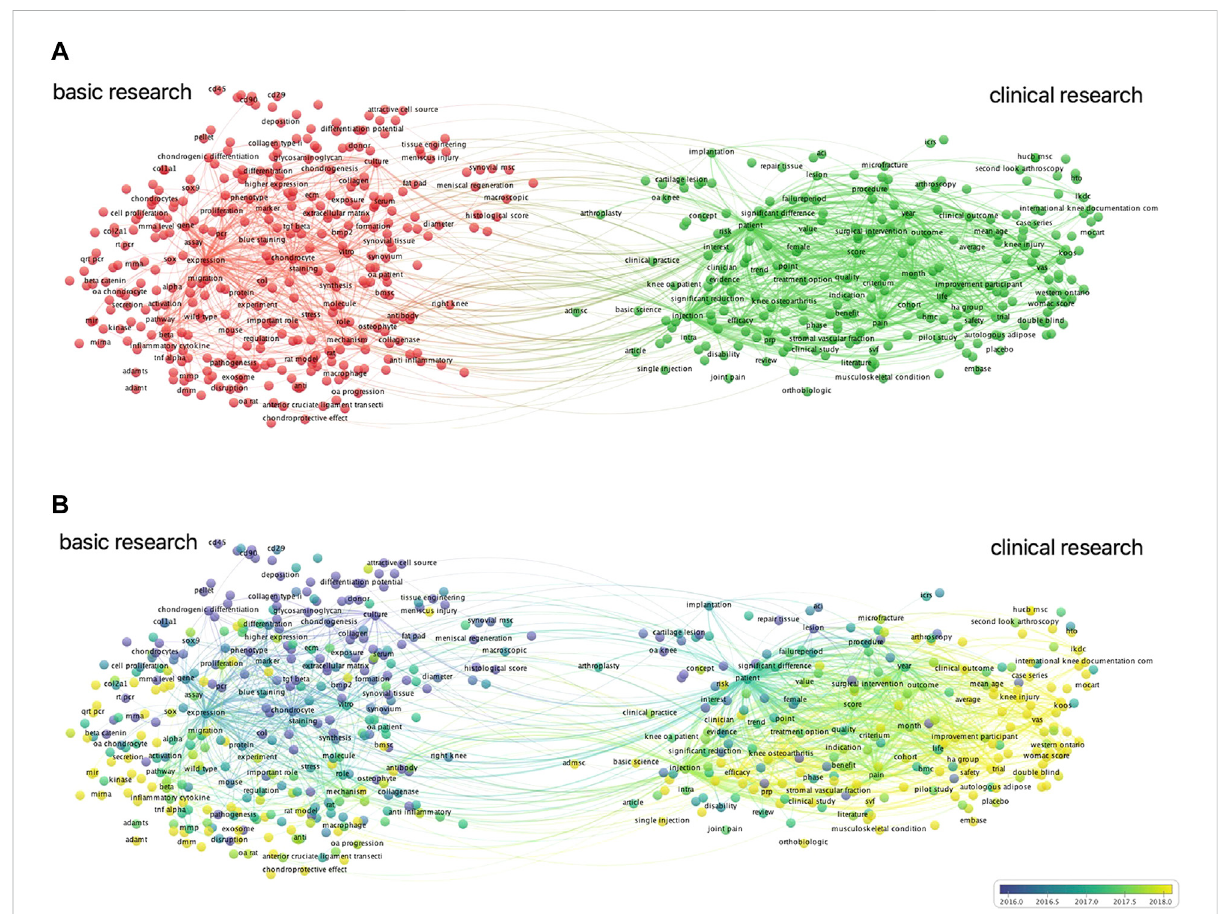
FIGURE 7 Co-occurrence analysis of all theme terms regarding stem cell therapy for KOA research. (A) Red cluster represents clinical research and green cluster represents basic research. (B) Co-occurrence of theme terms overlaying the visualization indicates the distribution of themes in different periods in clinical and basic